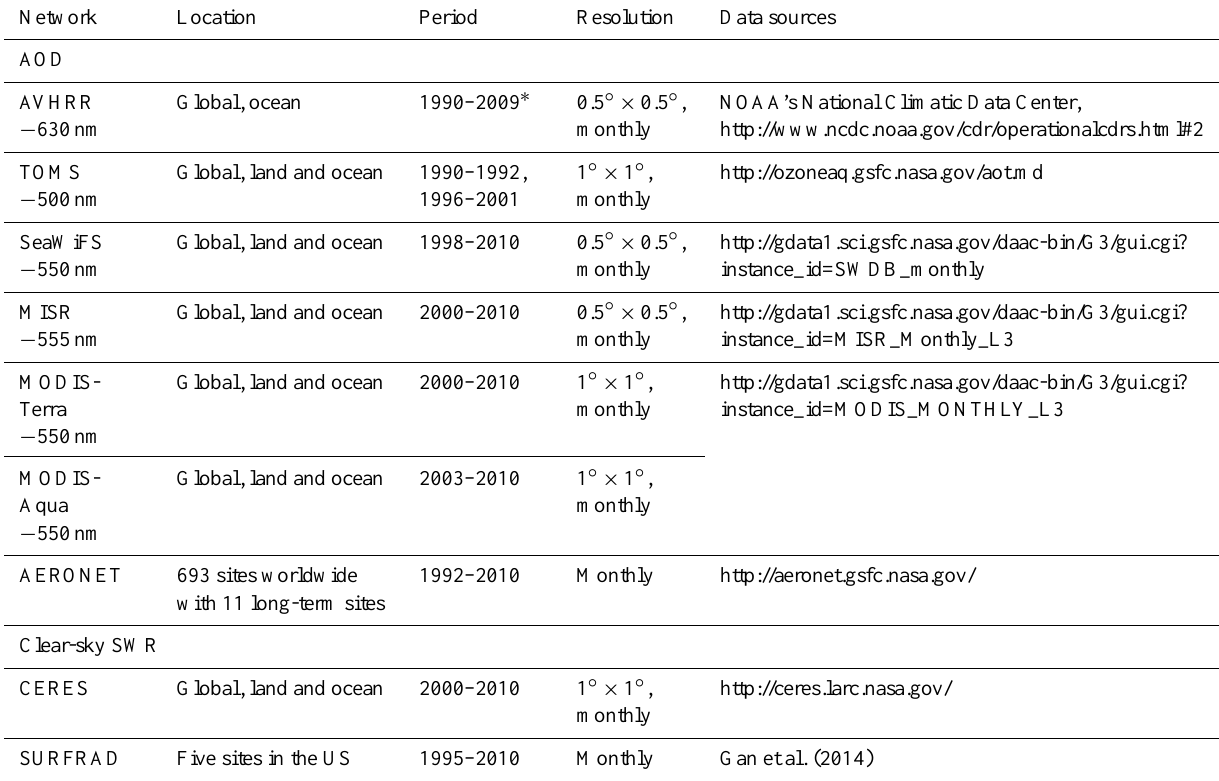
Table 1. Summary of long-term observations used in this